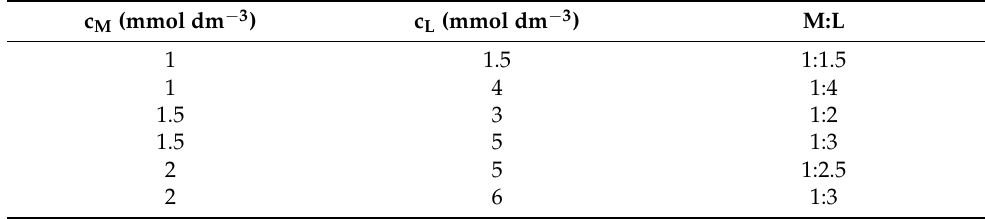
Table 2. Experimental conditions used for the M n+ /Dop − systems in NaCl aqueous solutions. c M (mmol dm − 3 )